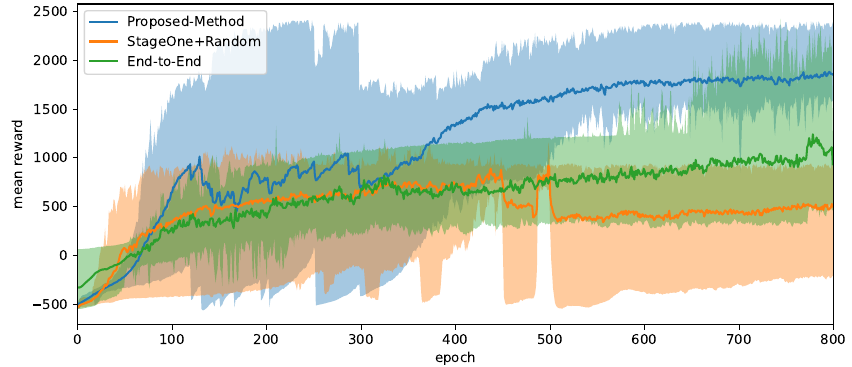
Figure 5. Training reward curves produced by different approaches. Vertical axis represents the average reward gained in one episode among all environments. Blue: proposed approach. Orange: hybrid method without curriculum stage one. Green: end-to-end aproach.